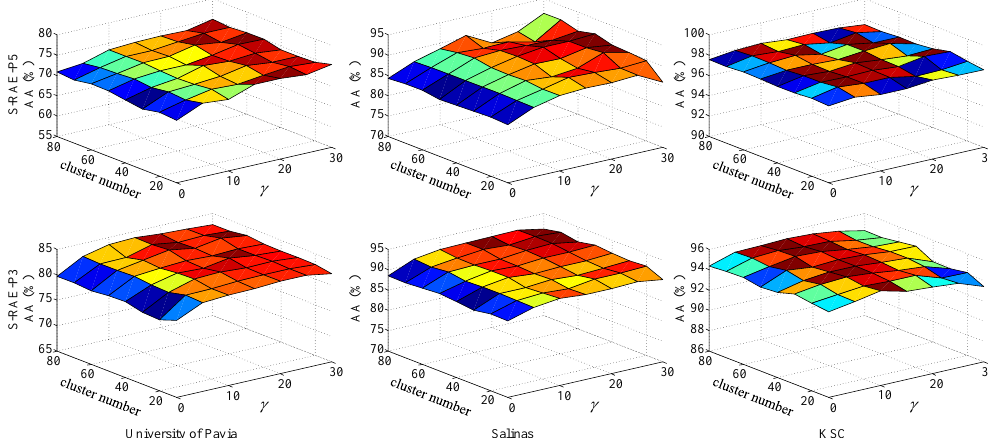
Figure 5. Effect of initial superpixel clusters number and weight coefficient γ on classification accuracy.